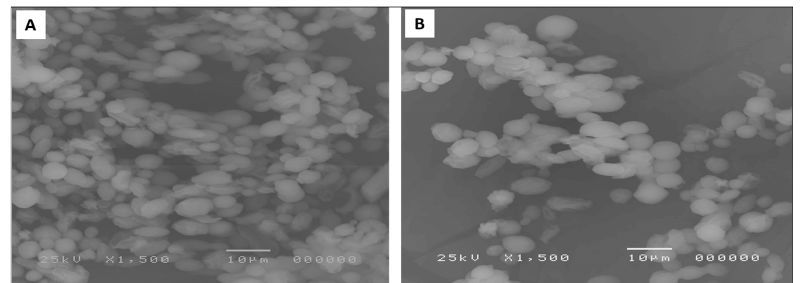
Figure 10. SEM micrograph showing biofilm formation by C. albicans (C6) isolate ( A ) before and ( B ) after AgNPs treatment.